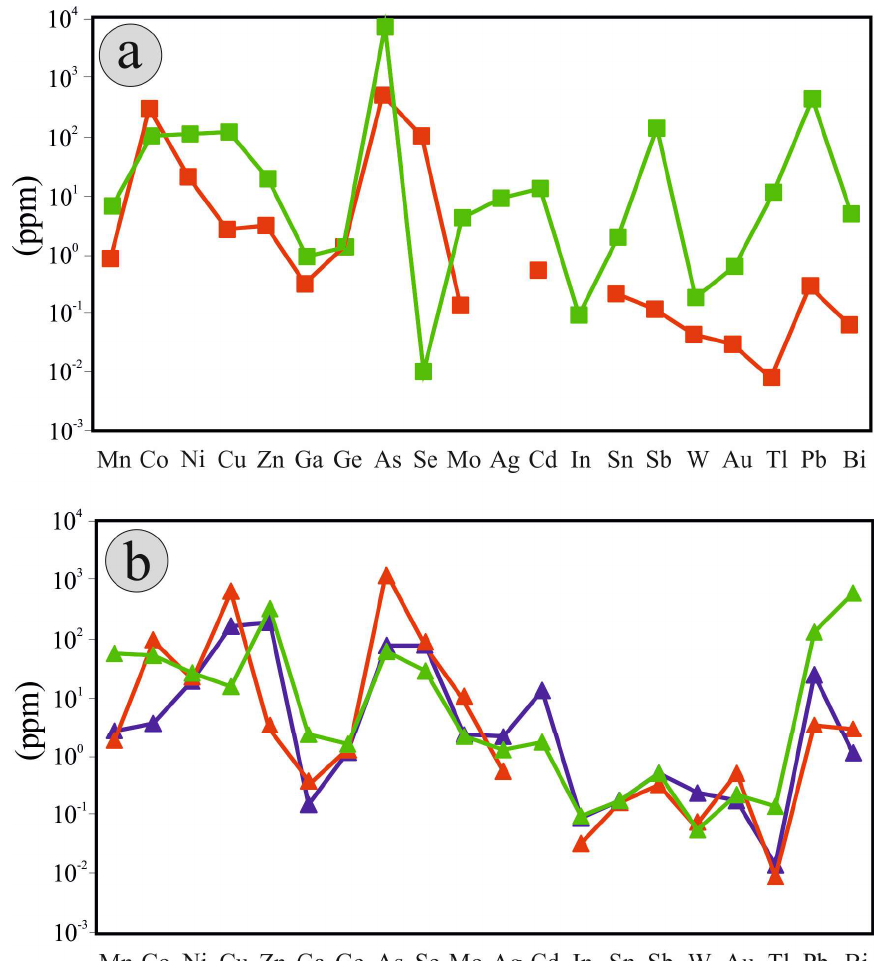
Figure 10. Multi-element variation plots (based on average values for each element) of pyrite from different vein types at the Konos Hill ( a ) and the Pagoni Rachi ( b ) porphyry-epithermal prospects (symbols as in Figure 8; values in ppm).